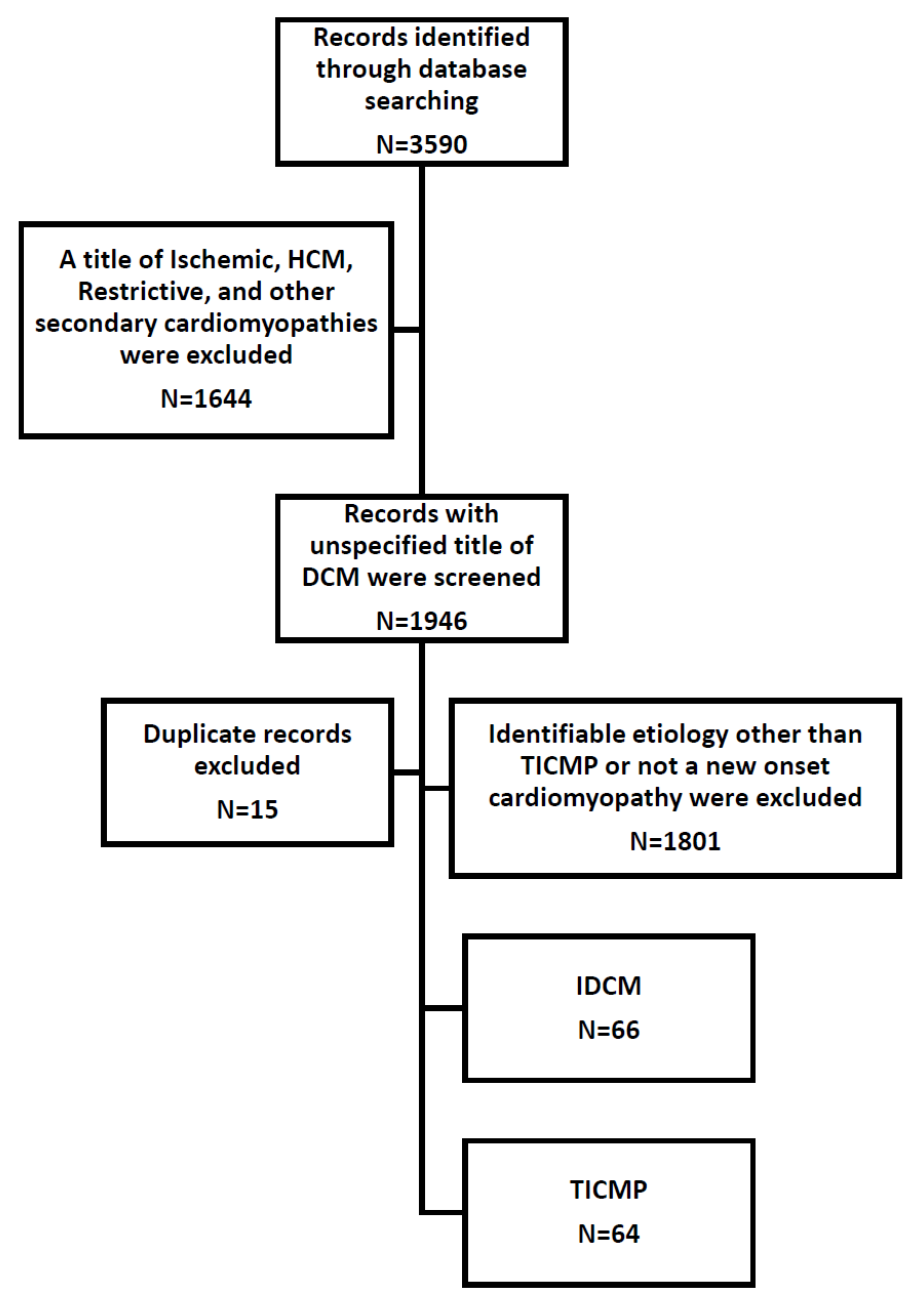
Figure 1. Flow chart of study population. DCM — dilated cardiomyopathy; HCM — hypertrophic cardiomyopathy; IDCM — idiopathic dilated cardiomyopathy; TICMP — tachycardia-induced cardi- omyopathy.